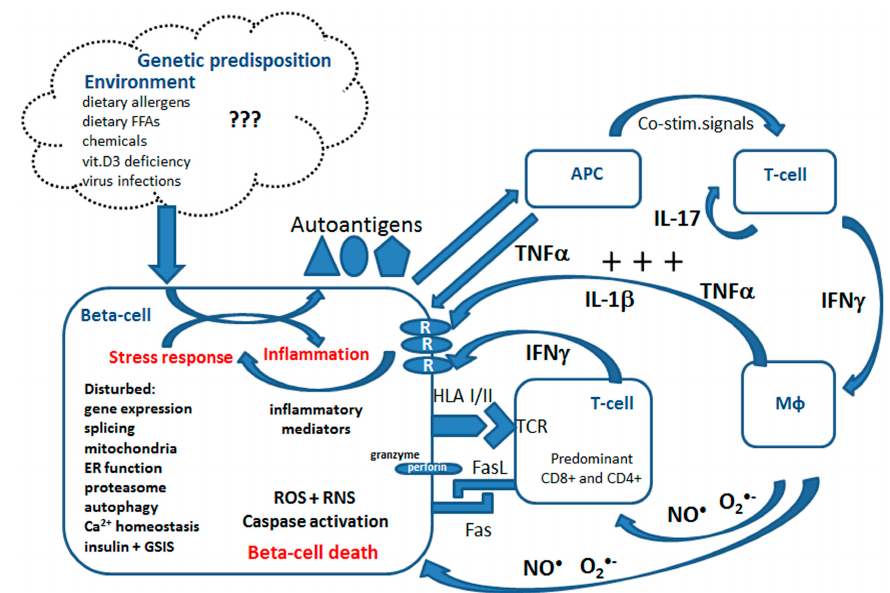
Figure 1. Model of cytokine-mediated beta-cell death in T1DM. In genetically predisposed individuals various environmental factors trigger the autoimmune response aimed at pancreatic beta-cells. Environmental triggers lead to beta-cell stress and release of autoantigens, which are processed and presented by antigen-presenting cells (APC). This leads to T-cell and macrophage (M Φ ) activation. Consequently proinflammatory cytokines and radicals (NO ● , nitric oxide and O 2 ●− , superoxide anion radicals) as well as perforin-granzyme mediators are released in the vicinity of beta-cells. Proinflammatory cytokines potentiate autoimmune reaction by stimulation of CD8+ and CD4+ T-cells. Activated immune cells interact with beta-cells via FasL-Fas and also via HLAI/II-TCR systems. The action of proinflammatory cytokines requires the binding and activation of cytokine